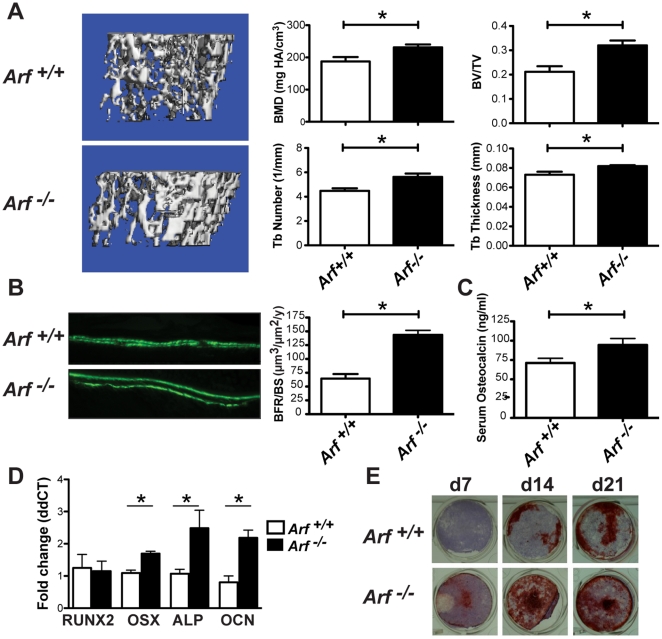
Loss of the Arf tumor suppressor resulted in increased bone formation and enhanced osteoblast differentiation.a) µCT analysis of tibias from 8-week-old female Arf
+/+ versus Arf-/- littermates (n = 6/genotype) mice. Bone mineral density (p = 0.0289), trabecular bone volume (BV/TV) (p = 0.0074), trabecular number (p = 0.0117) and trabecular thickness (p = 0.0252) were significantly increased in Arf-/- tibias. b) Bone formation was visualized by double calcein labeling 7d and 2d prior to sacrifice and visualized in the calveria. The distance between labels is directly proportional to bone formation. Arf-/- mice showed a significant increase in bone formation rate per bone surface (p = 0.0211). c) Serum osteocalcin levels were significantly increased in Arf-/- mice (p = 0.0376). d) Long bones of 8-week-old Arf-/- mice expressed increased transcripts of OB differentiation markers by quantitative RT-PCR (n = 3/genotype). Data is represented as fold change following normalization to cyclophilin levels. RUNX2 = cbfa1, OSX = osterix, ALP = alkaline phosphatase, OCN = osteocalcin. Significance (*) indicates p<0.05 by Student's T-test. e) In vitro differentiation of OB from bone marrow stromal cells under osteogenic conditions (β-glycerophosphate and ascorbic acid). Cells were co-stained for alkaline phosphatase (ALP) expression (purple) and mineralization (Alizarin Red) at indicated days. Note the nearly complete mineralization (red stain) of Arf-/- wells present at each day as compared to punctate areas of mineralization present in Arf
+/+ wells. Representative of >3 independent experiments.